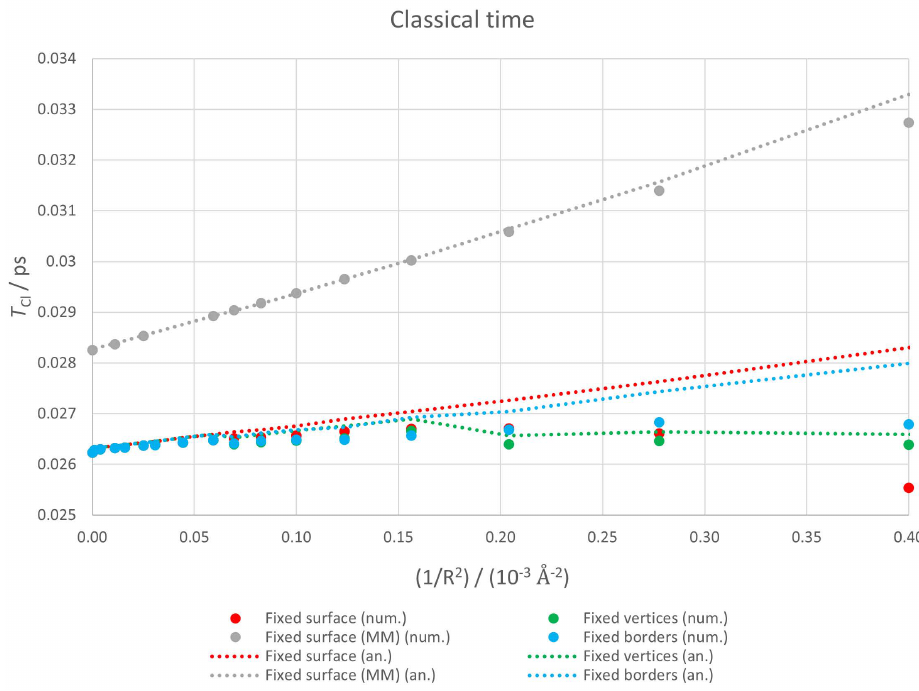
Figure 7. Classical times for a curved graphene nanoflake. Points correspond to numerical values while dotted lines represent analytical